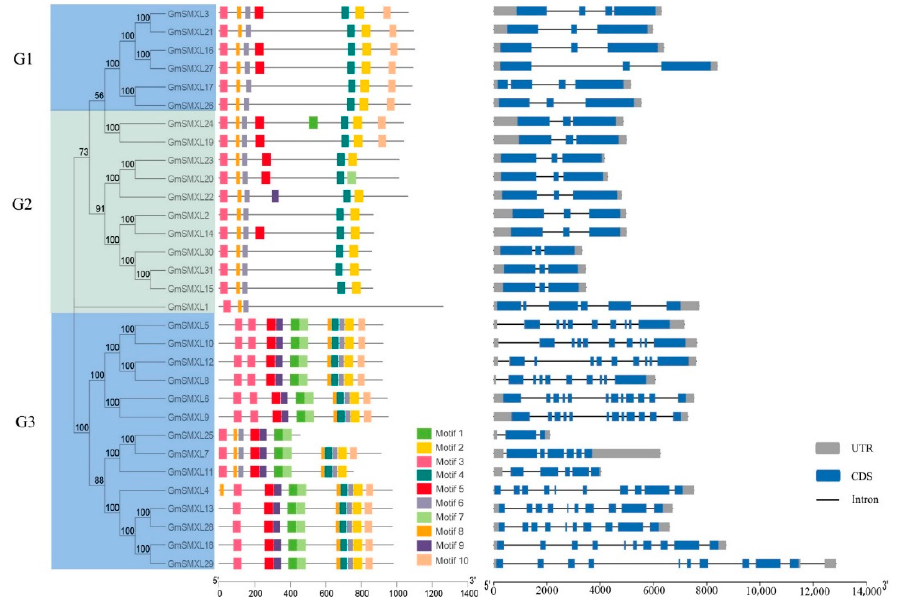
Figure 2. Phylogenetic analysis, gene structures and conserved motifs of GmSMXLs. The three columns in the diagram are phylogenetic tree, motif, and exon-intron in order from left to right. The sequence information for each MEME-motif was provided in Table S2.